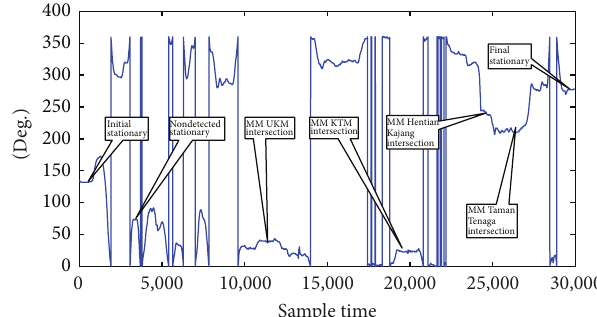
Figure 13: Stationary detection from heading signal in the first test. intersection and the threshold based stop detection coincided together. Next the vehicle stopped around 12800 sample time without an intersection for more than 5 s. Thus, the threshold algorithm correctly detected it as stationary state without the MM intersection. Finally, the vehicle again stopped without an intersection and the proposed algorithm detected it as a stationary state as shown in Figure